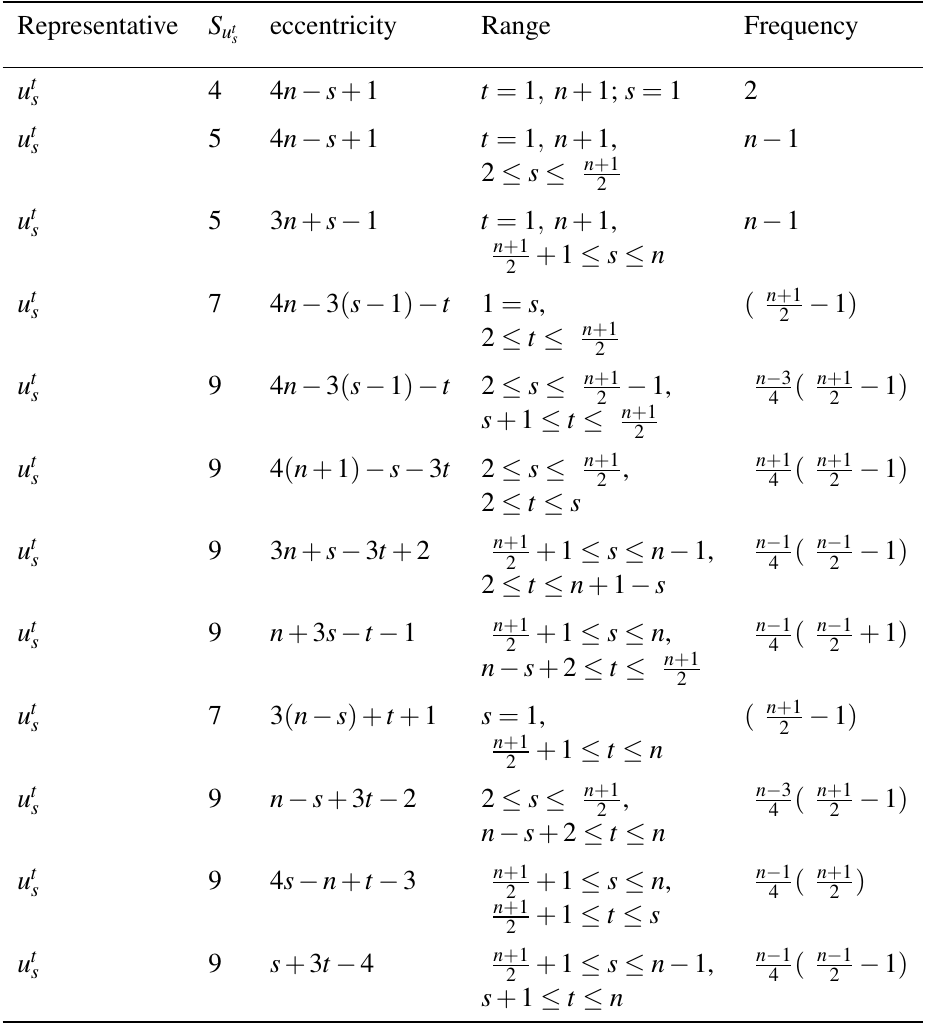
Table 2 Partition of vertices of the type u t mod 2 )